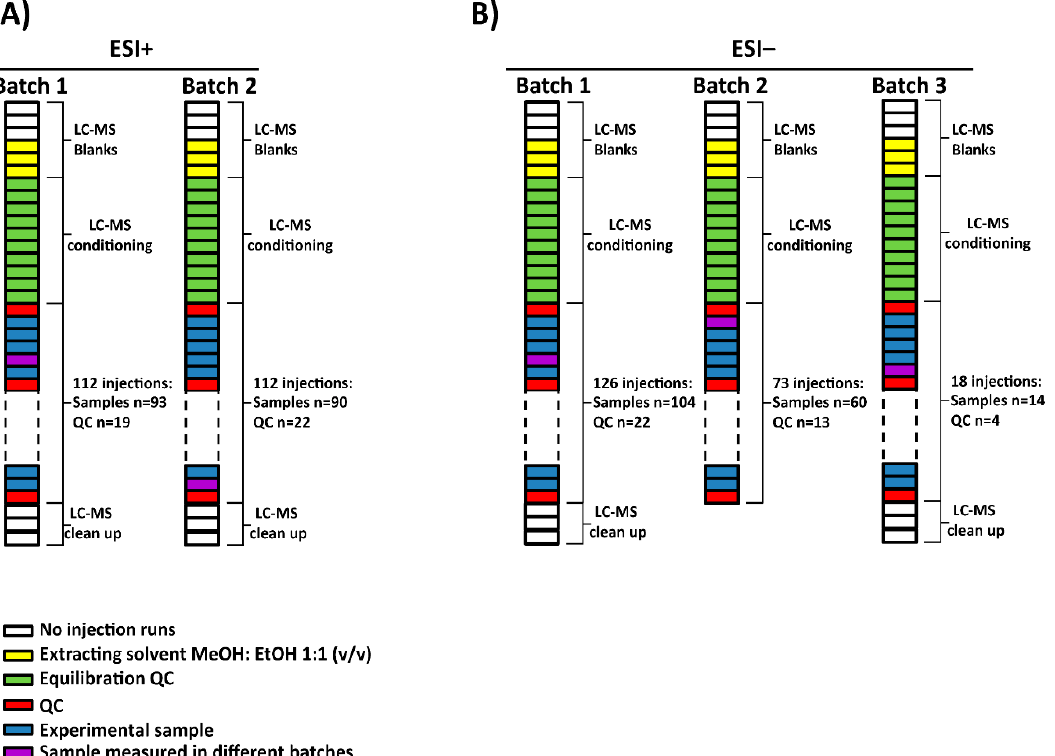
Figure 1. Experimental worklists and batches followed for ( A ) ESI+ and ( B ) ESI − modes. ( A ) Experimental samples were measured into two batches for ESI + while ( B ) in the case of ESI − mode, 3 batches were obtained due to an ‘instrument communication error’. NOTE. The source of the equipment was not cleaned up between batches 2 and 3 in ESI − mode.